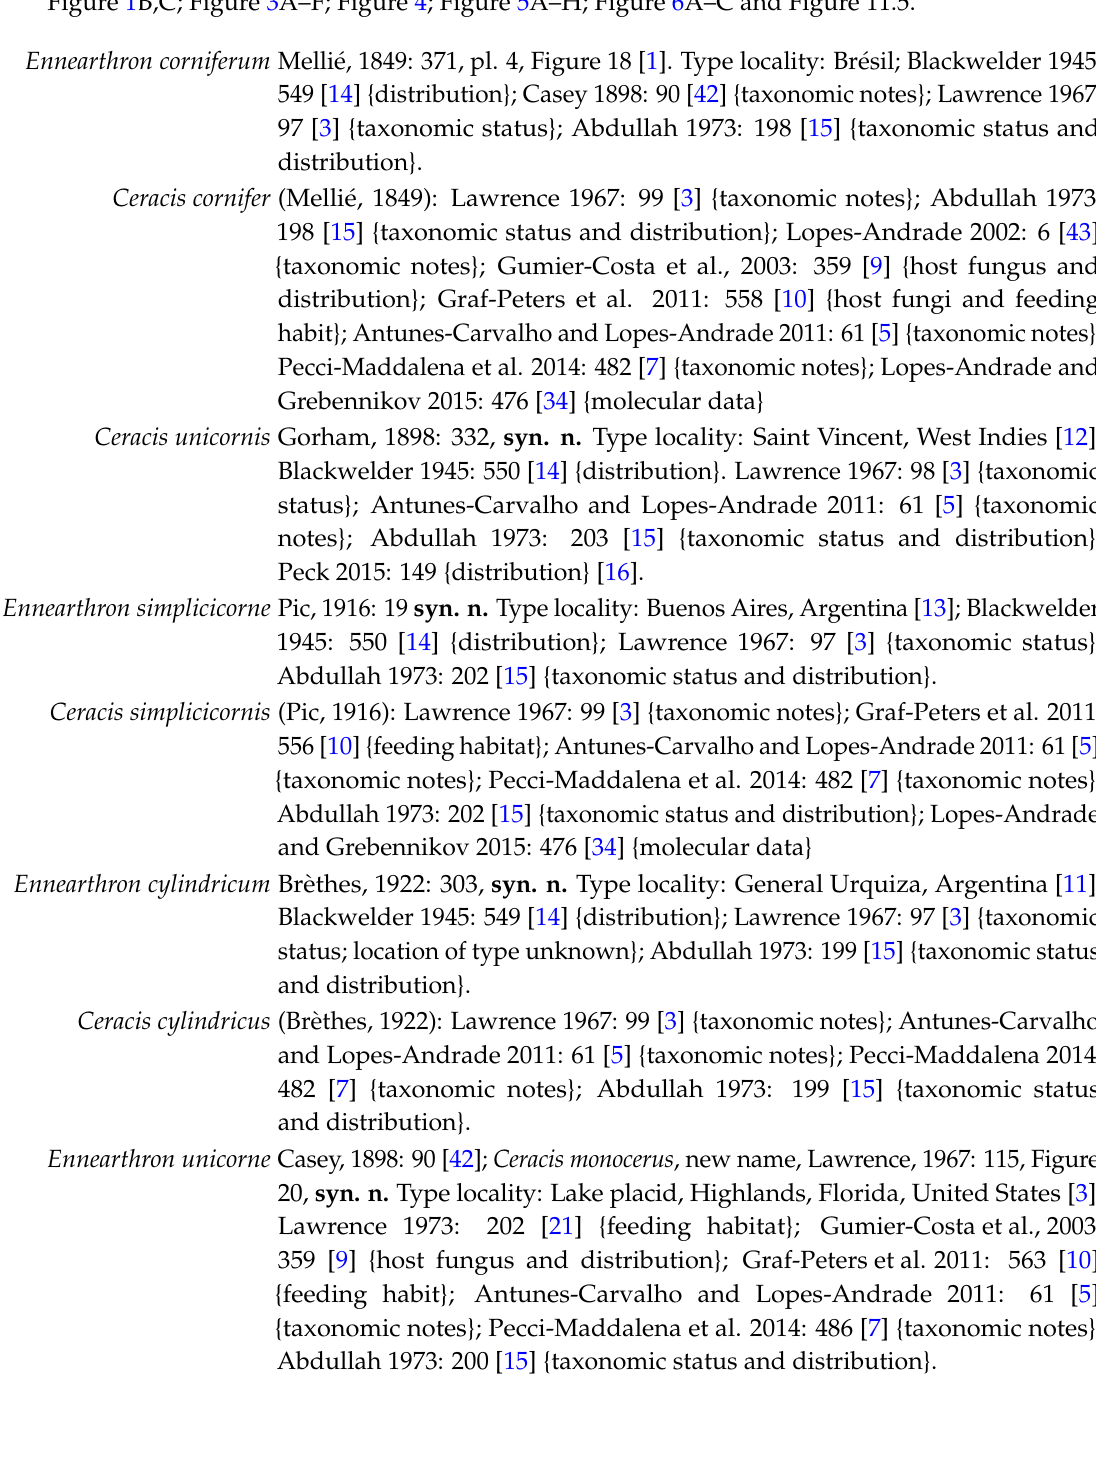
Figure 1B,C; Figure 3A–F; Figure 4; Figure 5A–H; Figure 6A–C and Figure